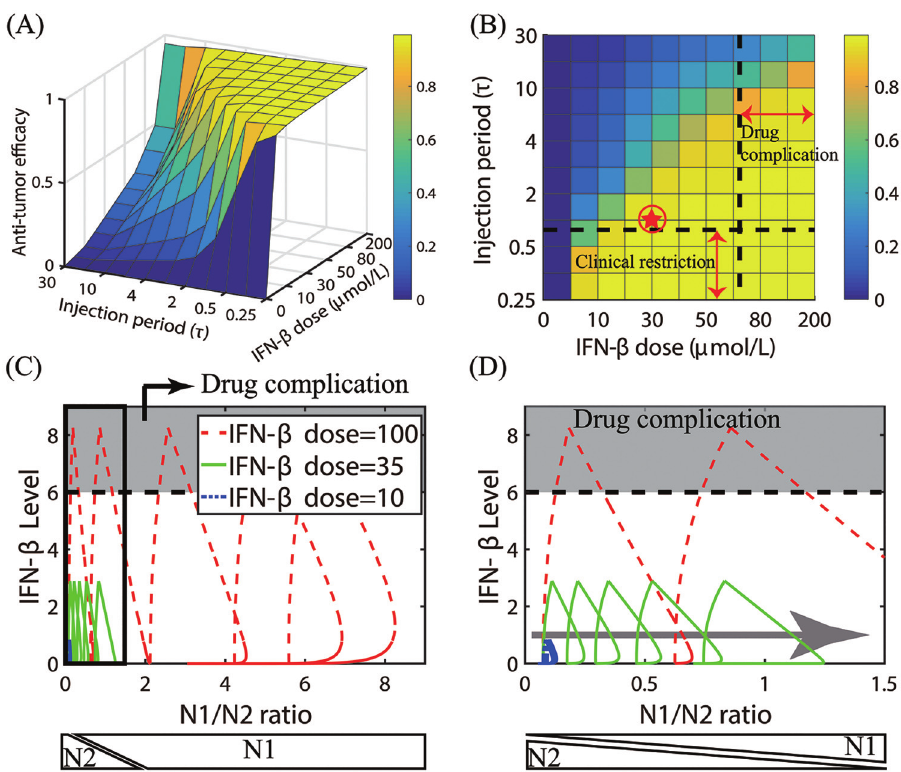
Fig 15. Optimal anti-tumor strategies of IFN- β injection. (A) Anti-tumor efficacy for various dose schedules ( τ s = 0.25, 0.33, 0.5, 1, 2, 3, 4, 5, 10, 15, 30 days ) and injection doses of IFN- β (5, 10, 20, 30, 40, 50, 60, 80, 100, 200 μmol / L ). (B) Illustration of anti-tumor efficacy for various schedules in (A) with practical restrictions at a clinic. The optimal dose and schedule are obtained for an intermediate IFN- β dose and an injection schedule without drug complication and under clinical restrictions (100 μmol / L , τ = 1 day ; red asterisk). (C) Trajectories of solutions ( Γ ( t ), S ( t )) in the s IFN- β - Γ plane in response to low (10 μmol / L , blue dashed line), intermediate (35 μmol / L , green solid line), and high (100 μmol / L , red dashed line) doses of IFN- β every day ( τ = 1 day ). Here, Γ ( t )(= I ( t )/ C ( t ))and S ( t ) are the N1/N2 ratio s and IFN- β concentration, respectively, at time t . (D) Enlarged figure from a subpanel (black box on the left) in (C). As the injection strength is increased (10 ! 35 ! 100), the trajectory transits to the N1-dominant system (gray arrow). However, the high dose IFN- β may lead to drug complications or extensive associated toxicity (gray zone on the top) [83–86]. N1 and N2 phenotypes on the bottom of panels (C, D) are determined from the N1/N2 ratio.